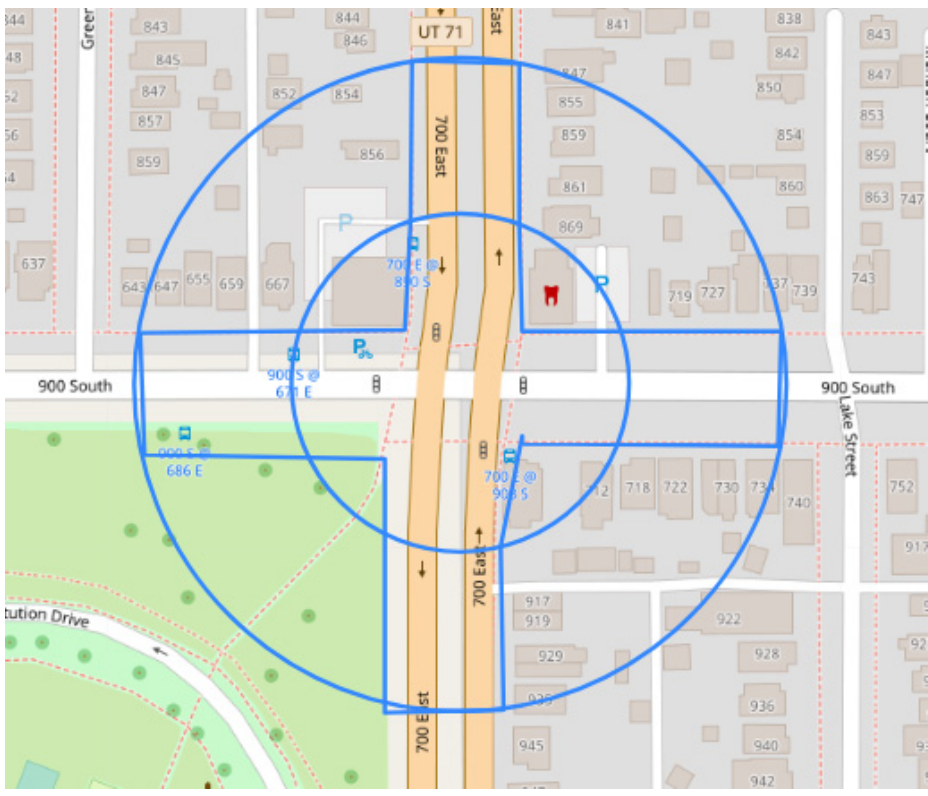
Figure 1. Geofences to Define Entry/Exit Gates.